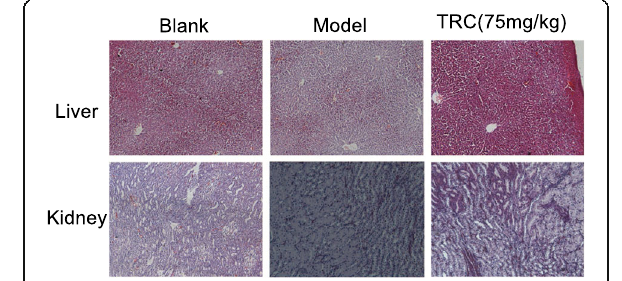
Fig. 7 Haematoxylin and eosin staining of kidney and liver tissue in rats. Histological findings of kidney and liver tissue in different rat groups were conducted during the CIA rats ’